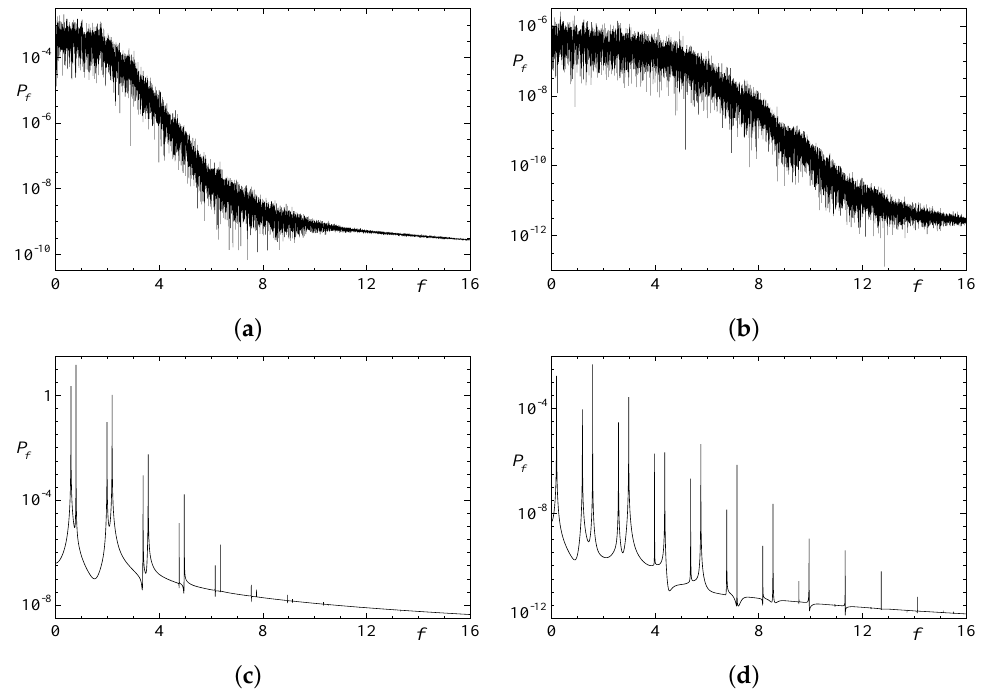
Figure 18. Temporal power spectra of the Fourier coefficients Re ˆ v 1 column) in the interval 50 ≤ t ≤ 533 in run 3 x 1.2 (a), (b) and in the interval 75 ≤ t ≤ 975 in run 1 x 3.3 (c),